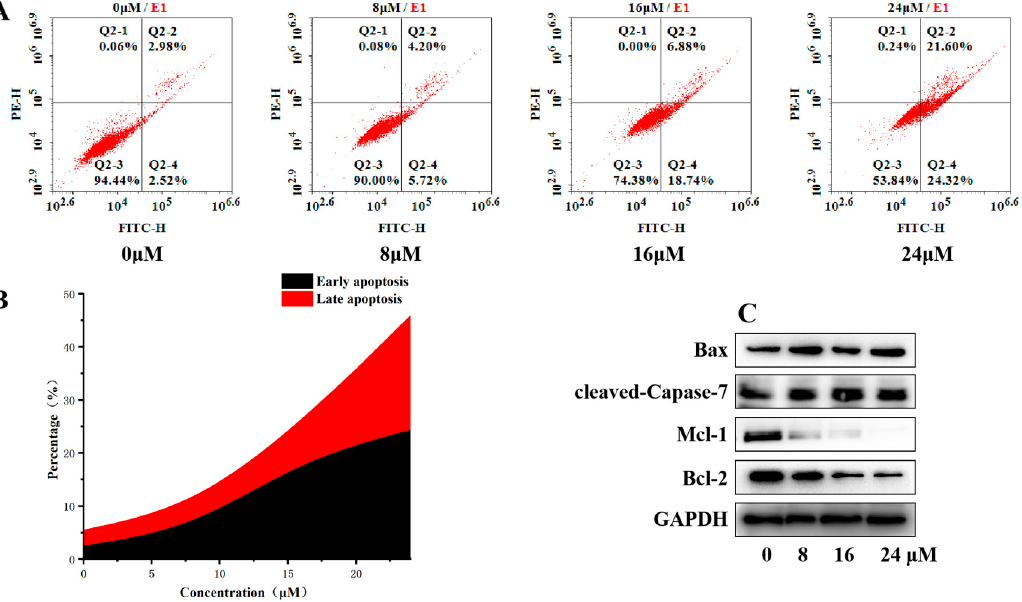
Figure 7. Effects of compound H12 on cell apoptosis. MGC-803 cells were treated with indicated concentrations of compound H12 for 48 h. ( A , B ) Apoptosis rates of treated MGC-803 cells; ( C ) level of apoptosis related proteins in treated MGC-803 cells.